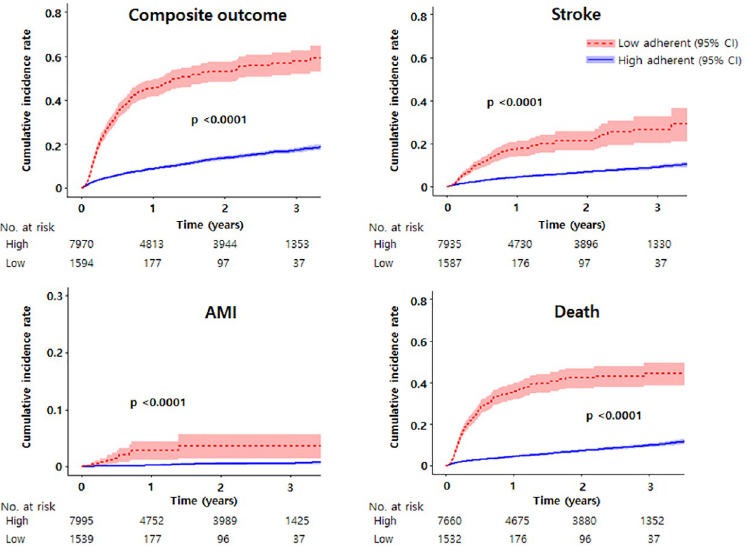
Fig 4. The cumulative incidence curves of clinical outcomes for patients with high and low adherence to NOACs: Composite outcome, stroke, acute myocardial infarction (AMI), and death. CI, confidence interval.